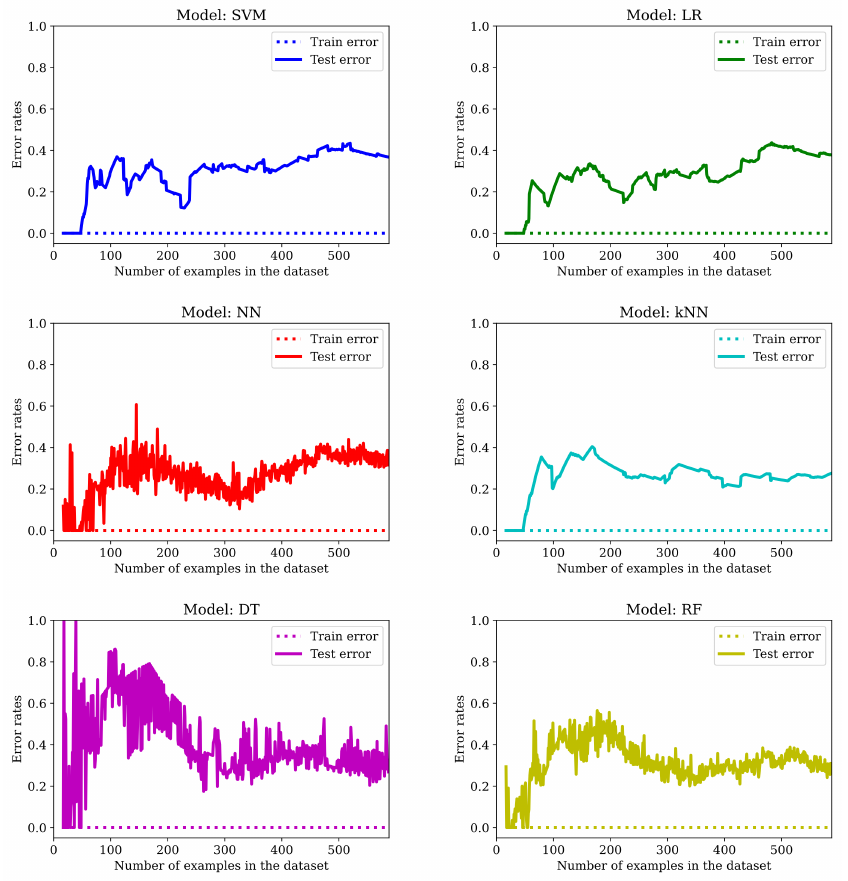
Figure 10. Evolution of errors rates with increasing number of examples in training and testing phase for the BigD